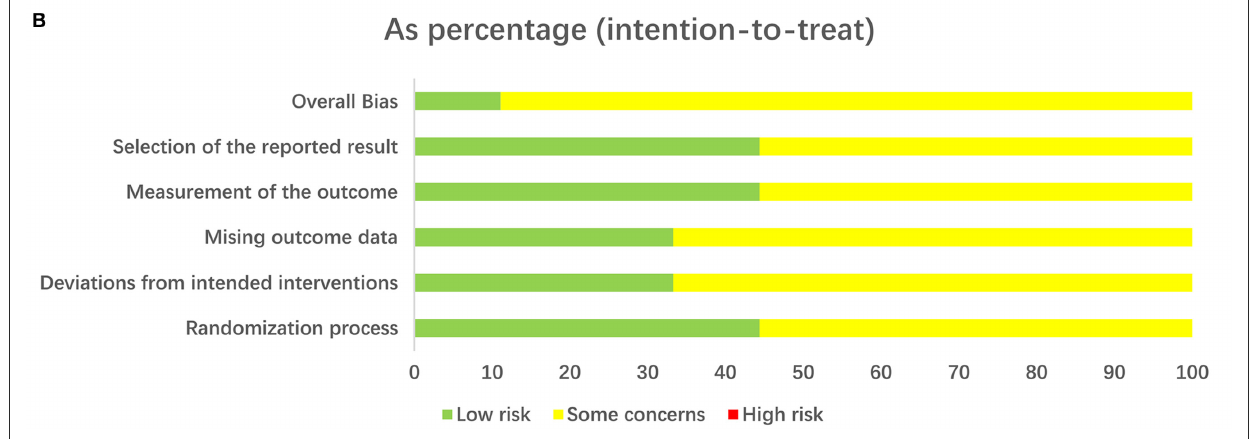
FIGURE2 Quality of studies included in the meta-analysis. (A) Risk of bias graph and summary for the including 11RCTs. (B) The distribution of the methodological quality of included 11RCTs.